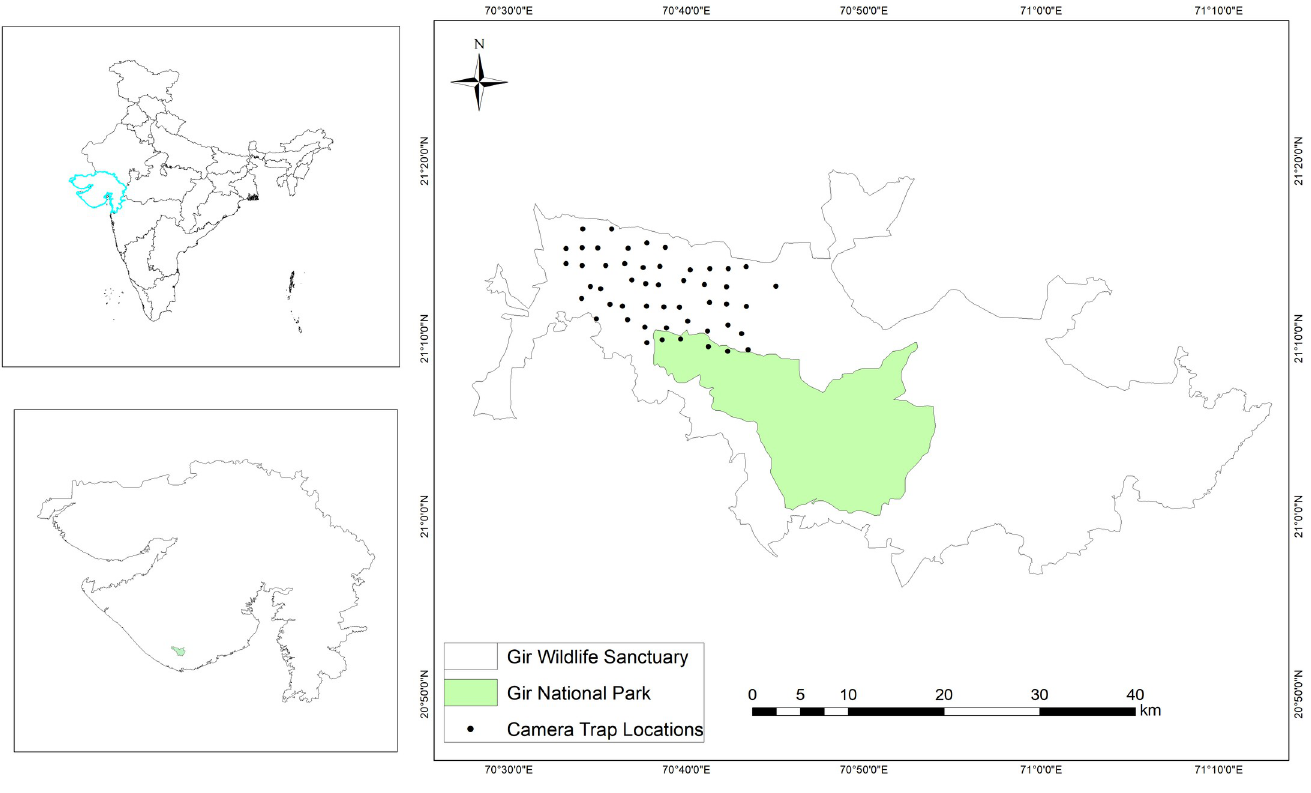
Fig 1. Map of the study area with locations of camera